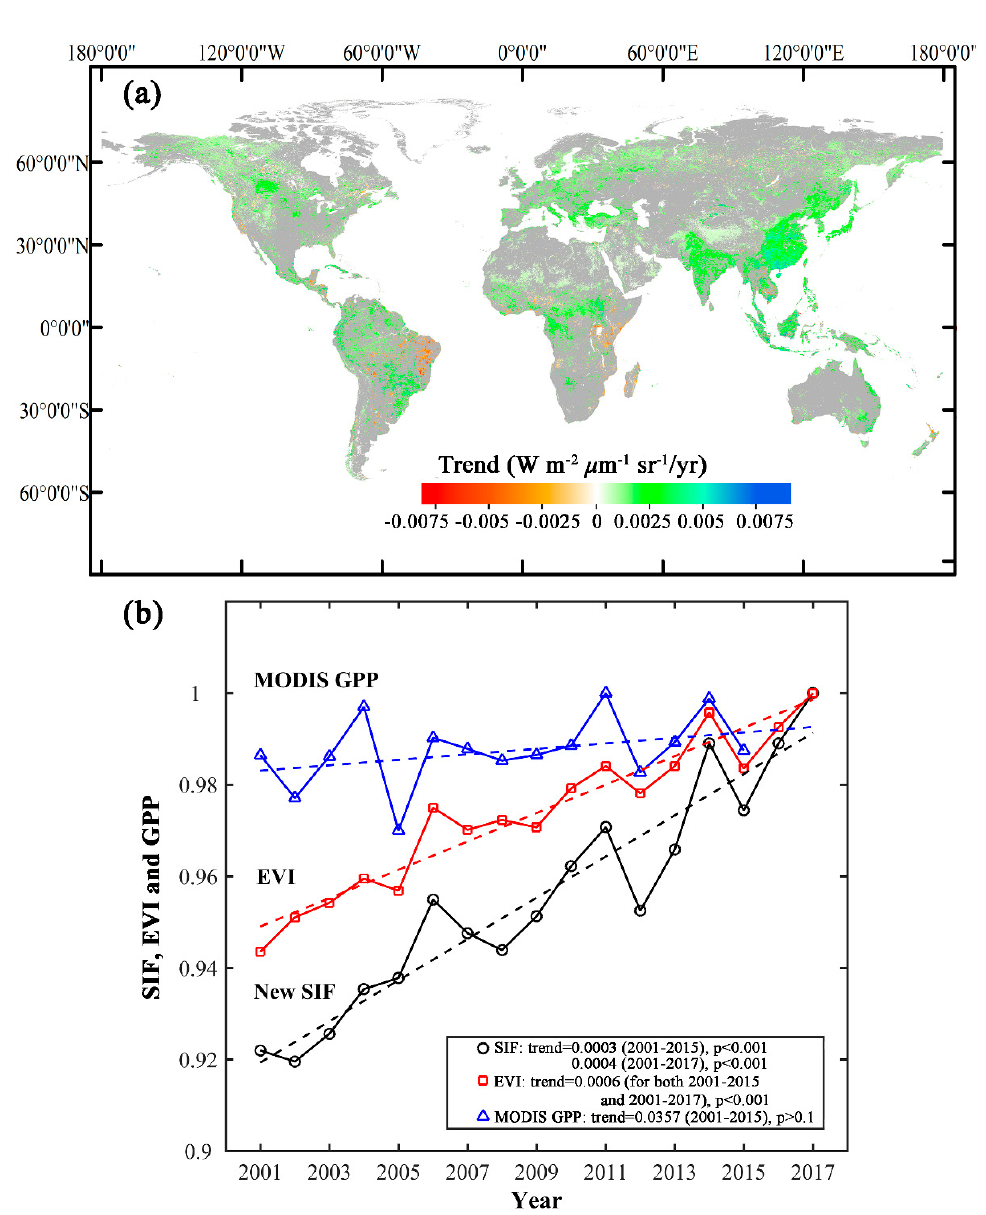
Figure 11. Spatial distribution of the trends (2001–2017) in annual global mean SIF ( a ) and the inter-annual variations and trends in global mean SIF, enhanced vegetation index (EVI), and MODIS GPP ( b ). The trends in SIF (unit: W m − 2 µ m − 1 sr − 1 ) and EVI were derived over both periods: 2001–2017 and 2001–2015, while the trend in MODIS GPP was based on the period 2001–2015 (unit: Pg C yr − 1 ). Gray color indicates grid cells with an insignificant trend detected by the Mann–Kendall (MK) test ( p > 0.05). In ( b ), the SIF, EVI, and GPP were normalized by their maximum values for better display purposes because they have different units and magnitudes. The trends were derived based on the original values of these variables.